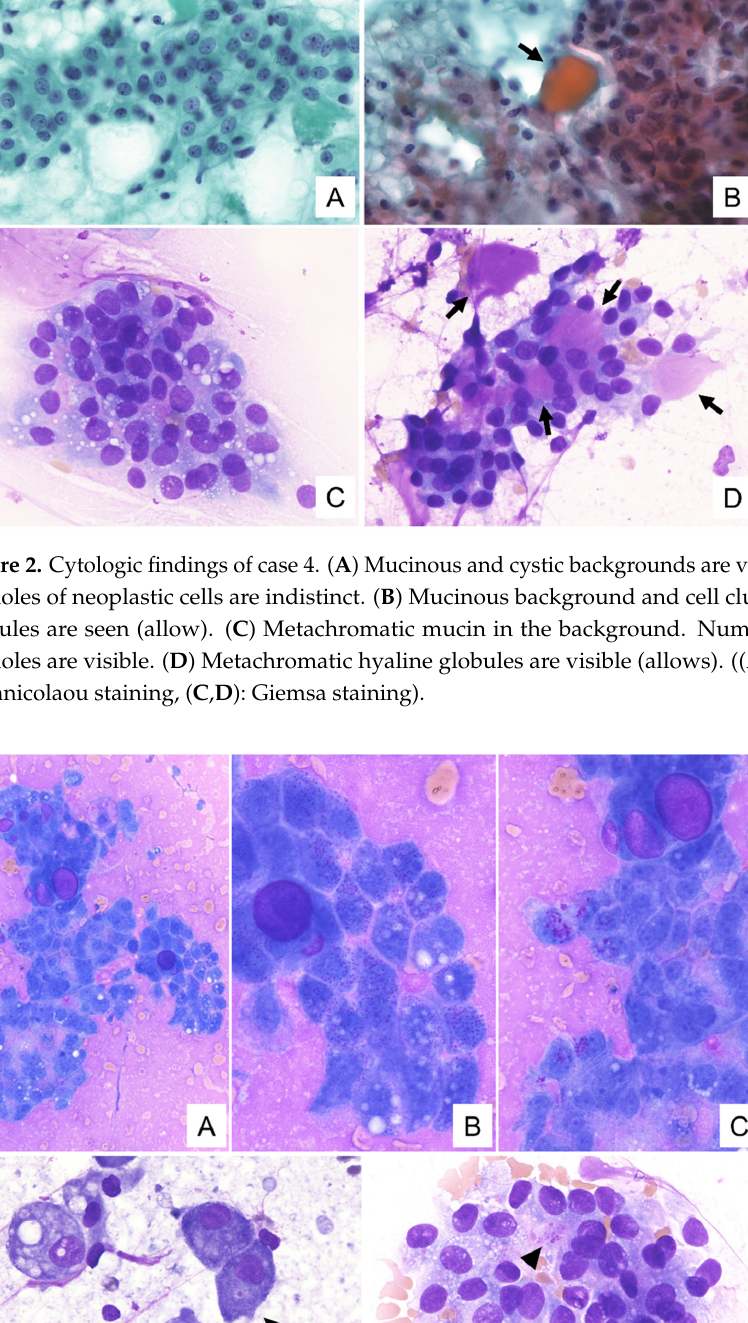
Figure 1. Cytologic findings of Papanicolaou staining. ( A ) Large clusters with papillary to dendritic pattern and hemorrhagic background are visible. ( B ) Blood vessels penetrate into the cell cluster. The neoplastic cells have vacuolated cytoplasm and enlarged nuclei, with fine chromatin and small, distinct single nucleoli. ( C ) The cell borders are distinct. The hyaline globule-like structures are seen. ( D ) Neoplastic cells have numerous cytoplasmic vacuoles, and some of them contain secretions or show intracytoplasmic lumina (allow) (( A – D ): Case 1. ( A ): ×100, ( B , C ): ×400, ( D ): ×600).